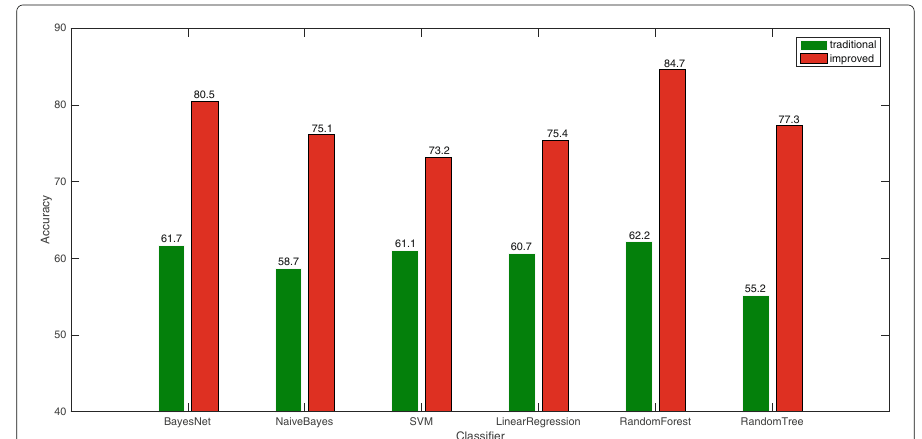
Fig. 4 The total number of words in the gender-specific thesauruses comparison